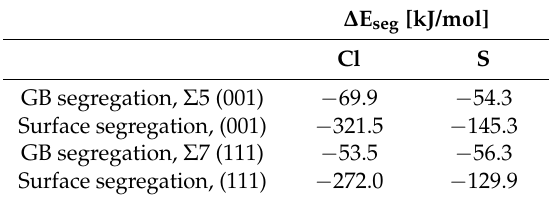
Table 1. Calculated energy release during segregation ∆ E seg of Cl and S in